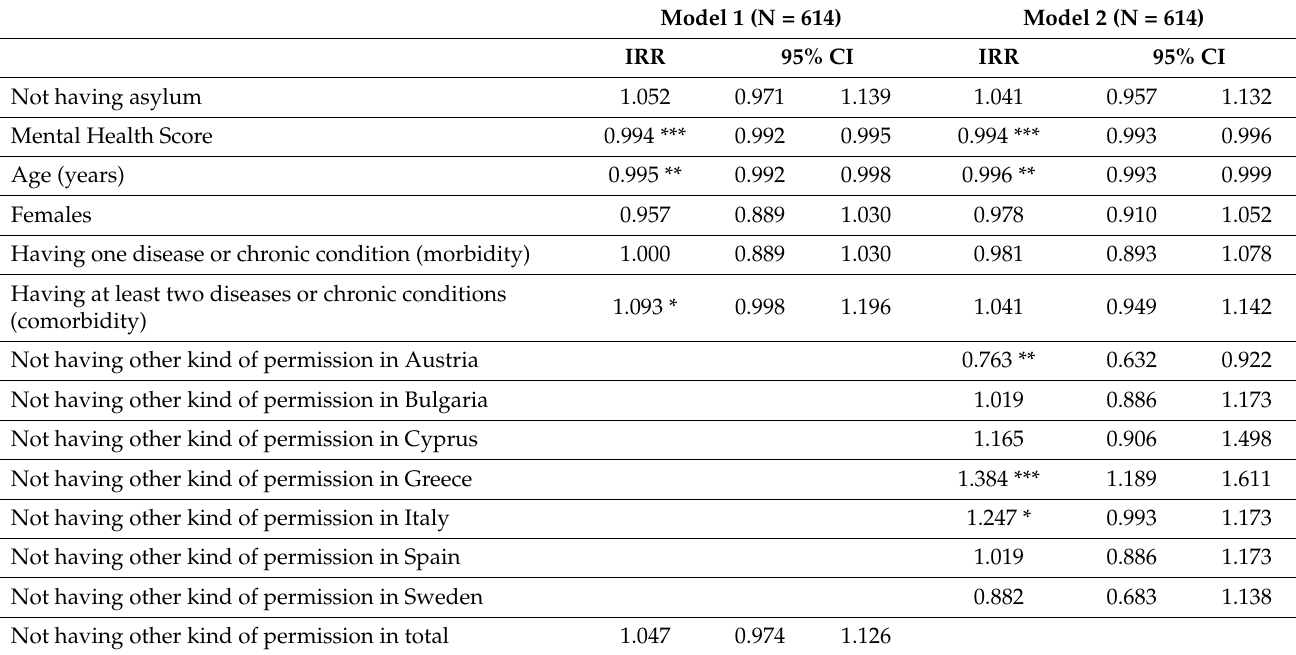
Table 6. Negative binomial regression investigating the impact of country of interview, permission to stay, and health status on Discrimination Scale to Medical Settings (dependent variable) in migrants and refugees. Estimates are presented as incidence rate ratio. Migrants and refugees from Germany, France, and Malta were excluded from the